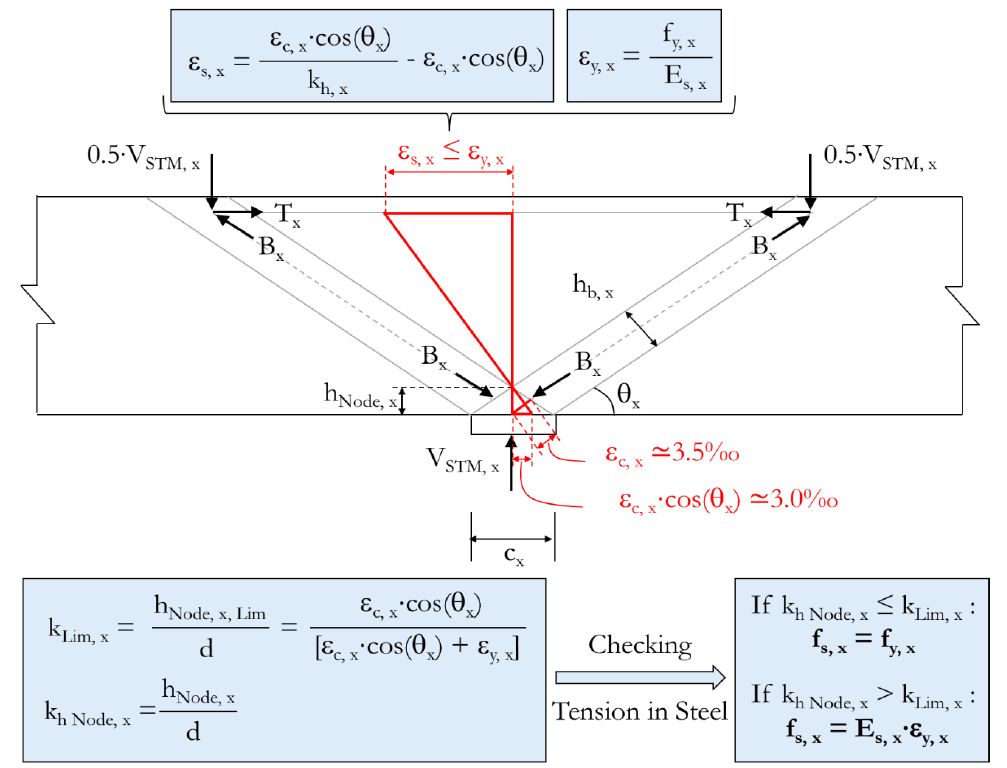
Figure 4. Compatibility of efforts with strains in the STM on